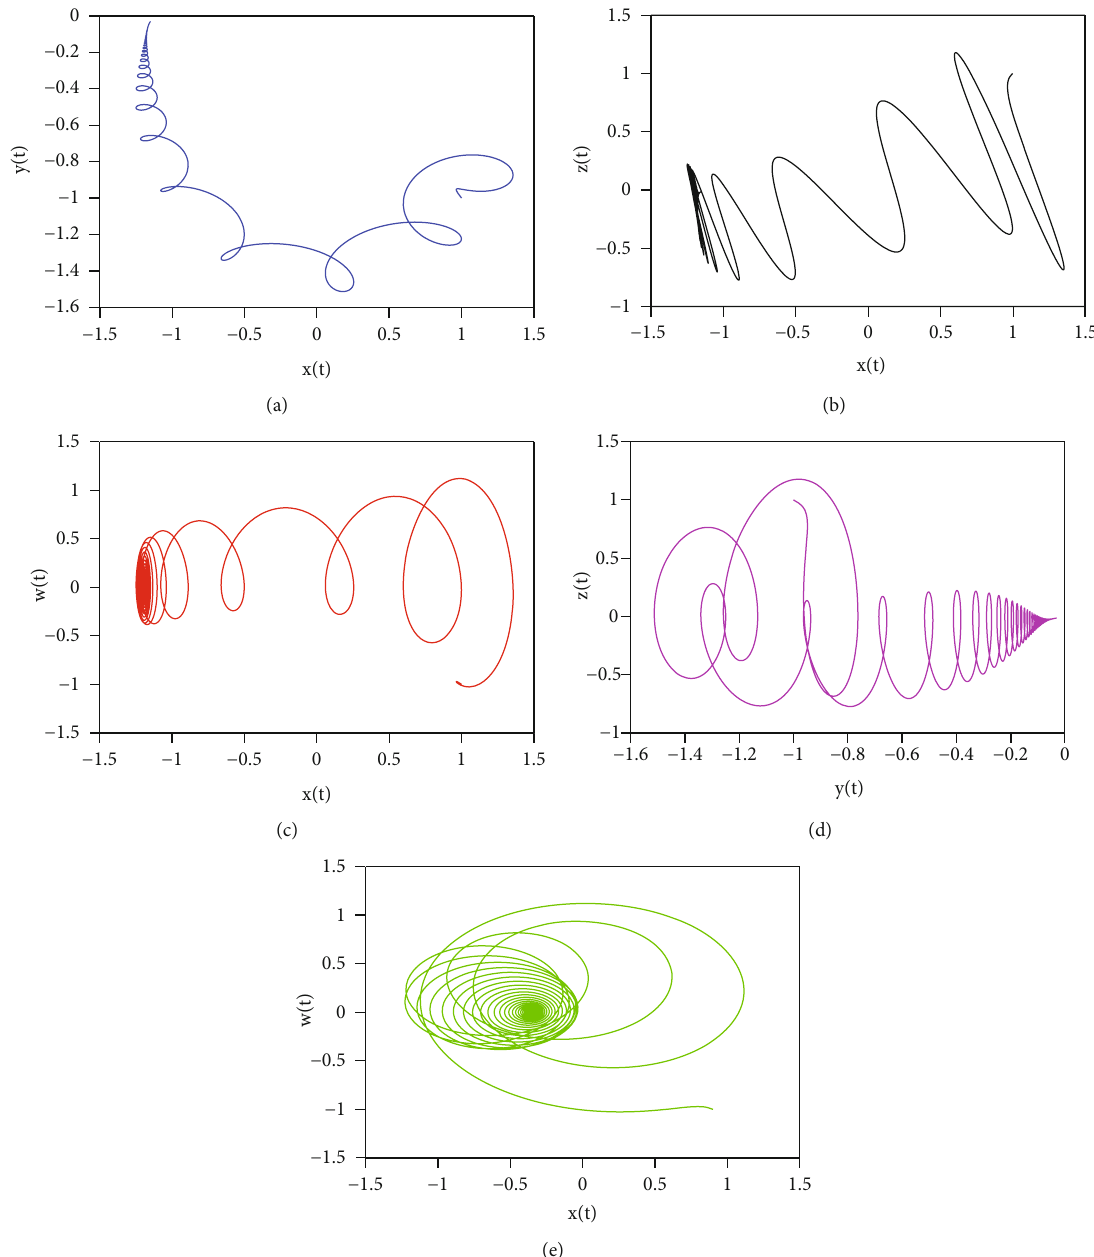
Figure 15: The behavior of di ff erent state variables of system 2 with fractional order ϖ = 0 : 98 and the parameters are considered as m = 2, n = 5